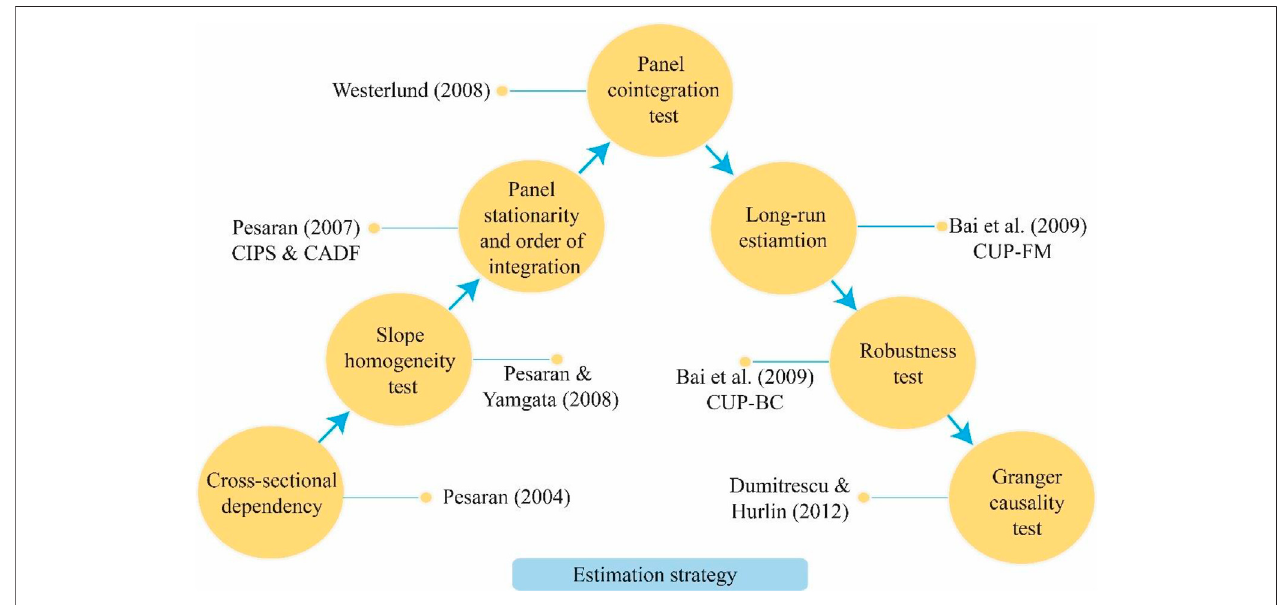
FIGURE 2 | Empirical estimation